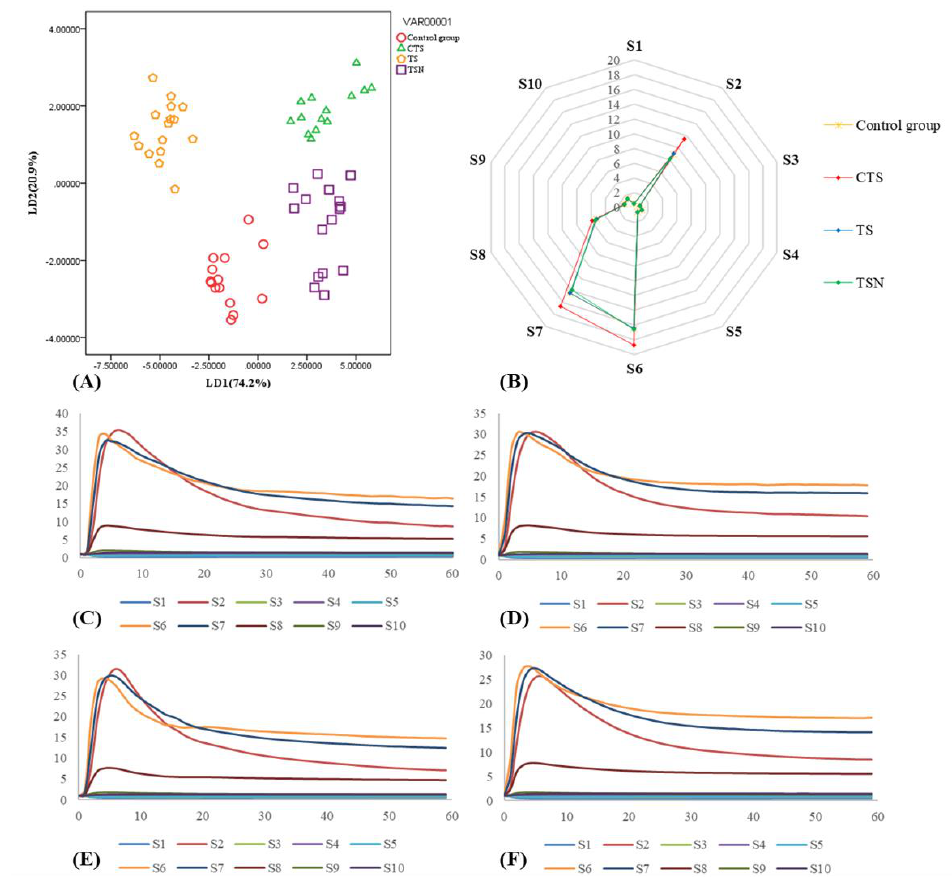
Figure 8. E-nose assay of grape juice after different sterilization treatments. ( A ) Linear discriminant analysis (LDA) results of grape juice under different sterilization treatments; ( B ) radar chart of E-nose response data of grape juice after different sterilization treatments; ( C ) sensor responses recorded using ten sensors in the E-nose for fresh grape juice; ( D ) sensor responses recorded using ten sensors of the E-nose for conventional thermal sterilization (CTS); ( E ) sensor responses recorded using ten sensors of the E-nose for TS; and ( F ) sensor responses recorded using ten sensors of the E-nose for TSN.